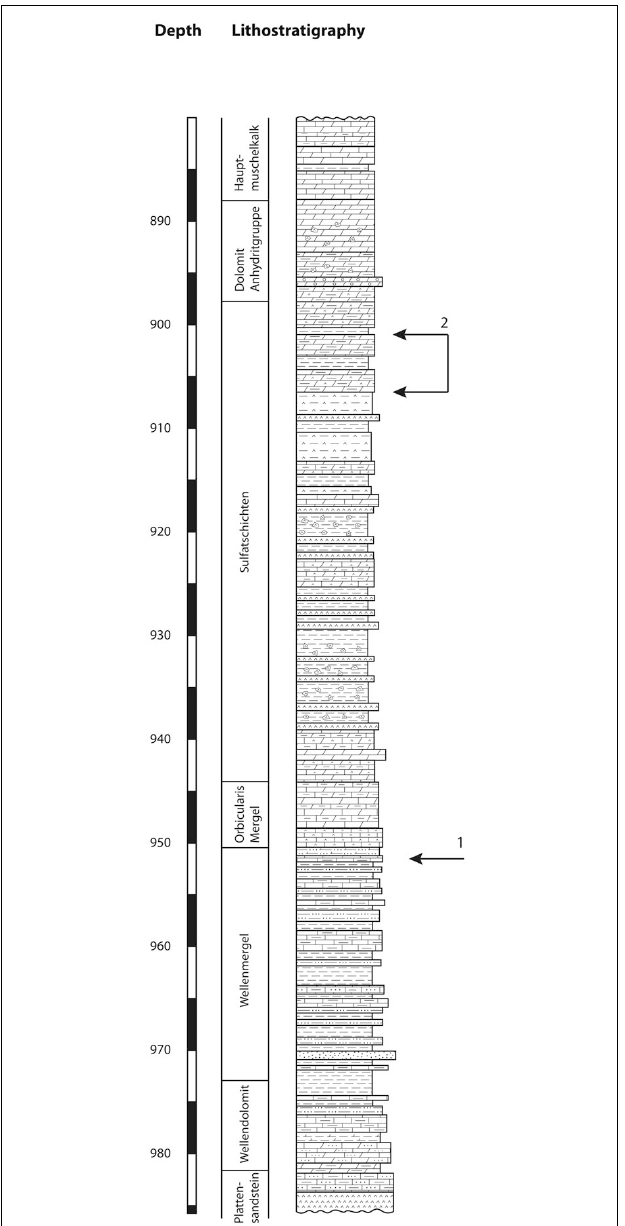
FIGURE 2 | Lithostratigraphic column of the Middle Triassic section of the Weiach core hole. 1, position of Afropollis ; 2, range of angiosperm-like pollen